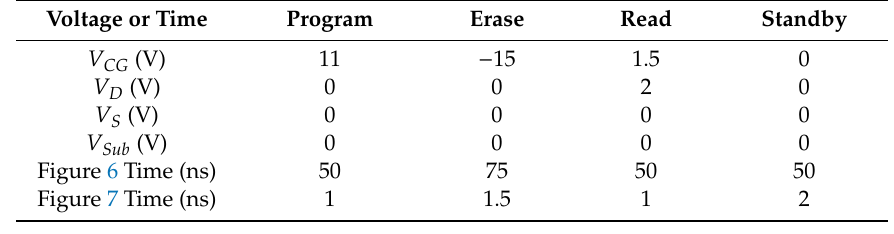
Table 2. Operation voltage and time of UFGM with p + FG.